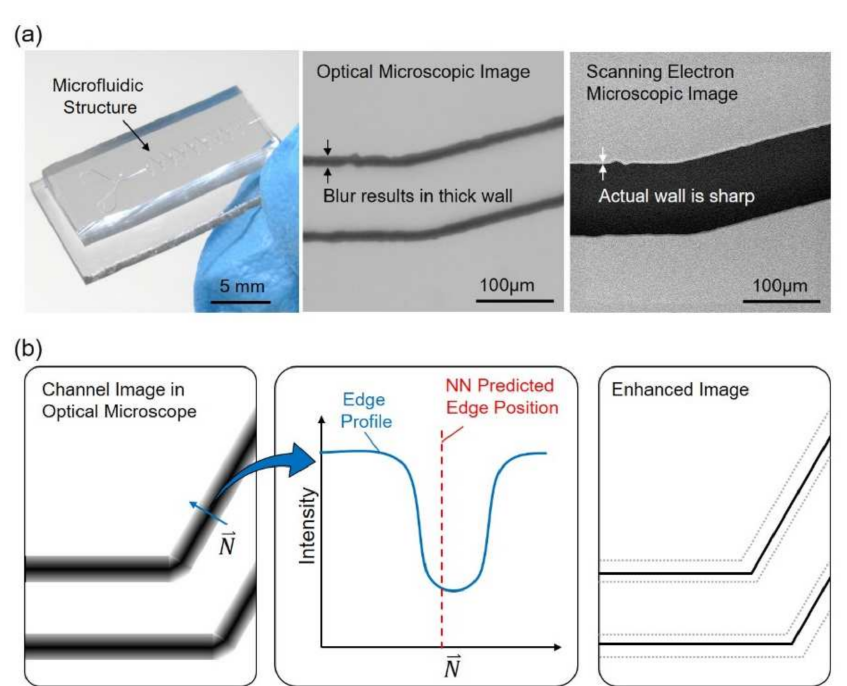
Figure 1. An overview of the proposed method for enhancing the resolution of an optical microscope (OM). ( a ) A microfluidic chip and its structure observed with an OM and a scanning electron microscopy (SEM). ( b ) The edges of the structure are in bold lines due to the optical effects. Artificial neural network is applied to predict the edge position and to enhance the